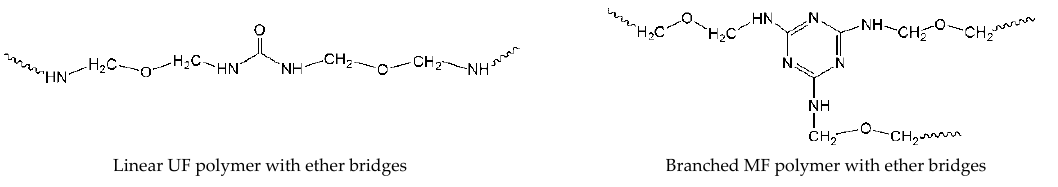
Figure 10. The UF and MF polymer structures containing ether bridges.